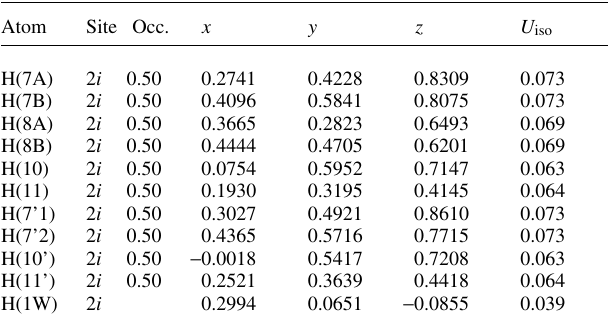
Table 2. Atomic coordinates and displacement parameters (in Å 2 )